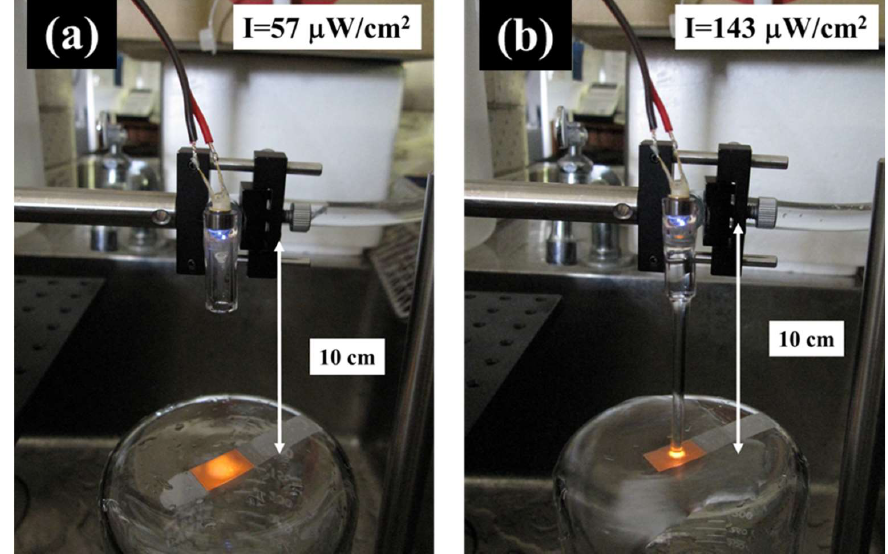
Figure 2. DUV fluence of the water-waveguide effect. The radiation power estimated by the intensity of the spectrum was ( a ) 57  W/cm 2 for DUV radiation without the water-waveguide effect and ( b ) 143 of the spectrum was ( a ) 57 µ W/cm 2 for DUV radiation without the water-waveguide effect  W/cm 2 for DUV irradiation with the water-waveguide effect. The enhancement of the DUV light intensity achieved with the water-waveguide effect is demonstrated by illuminating a phosphor tape.